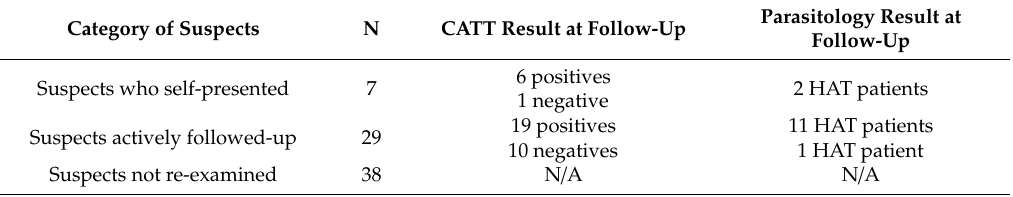
Table 1. Achievements of passive and active follow-up approaches with parasitology results.